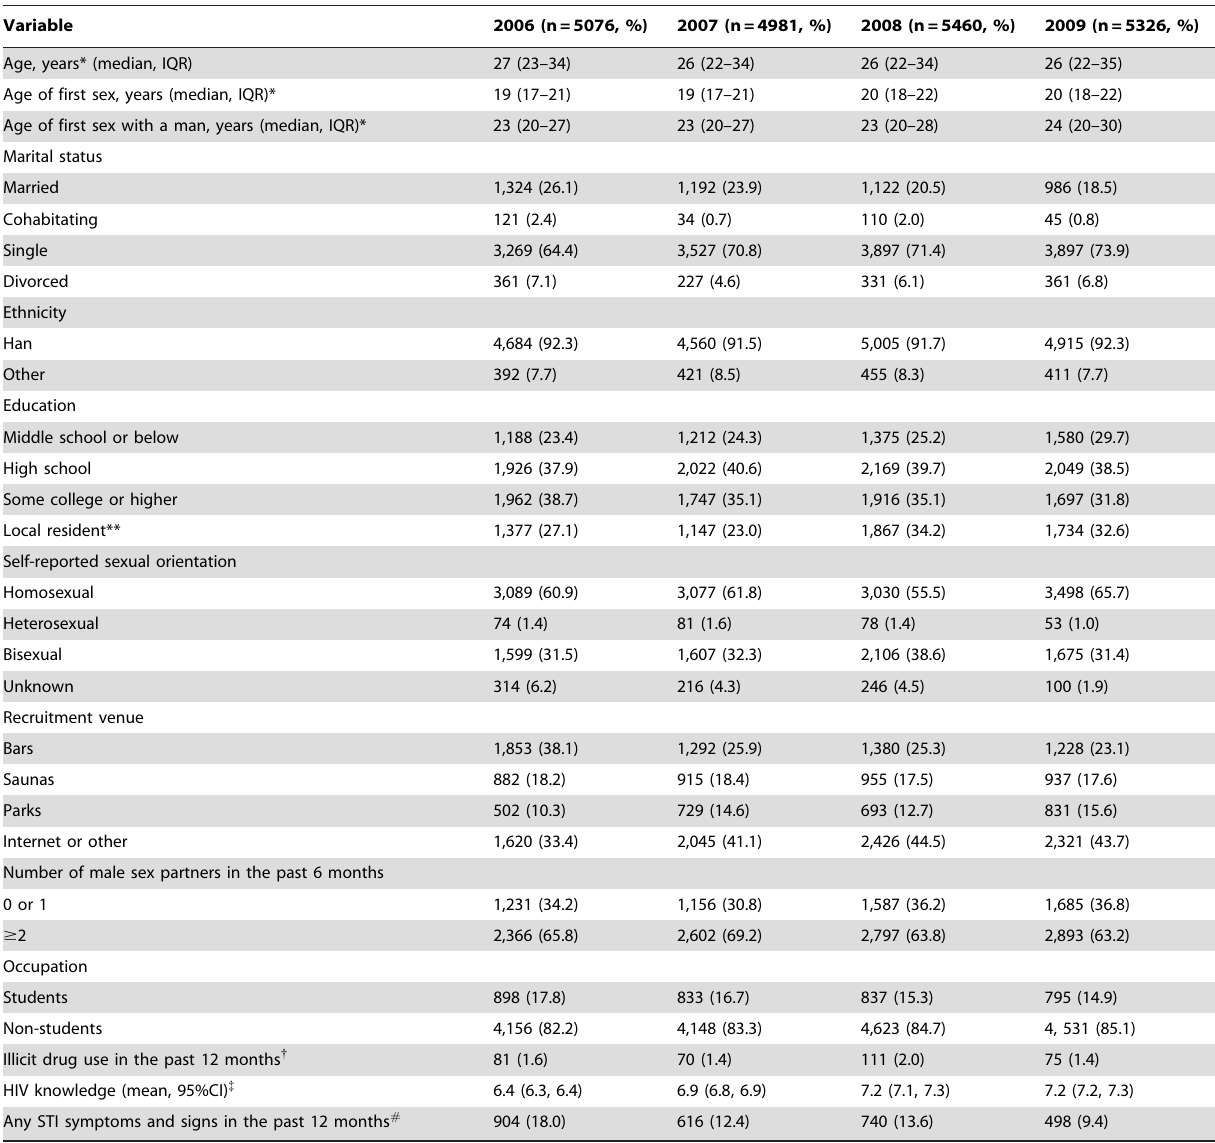
Table 2. Demographics and sexual behaviors of MSM surveyed in 16 Chinese cities from 2006 to 2009.